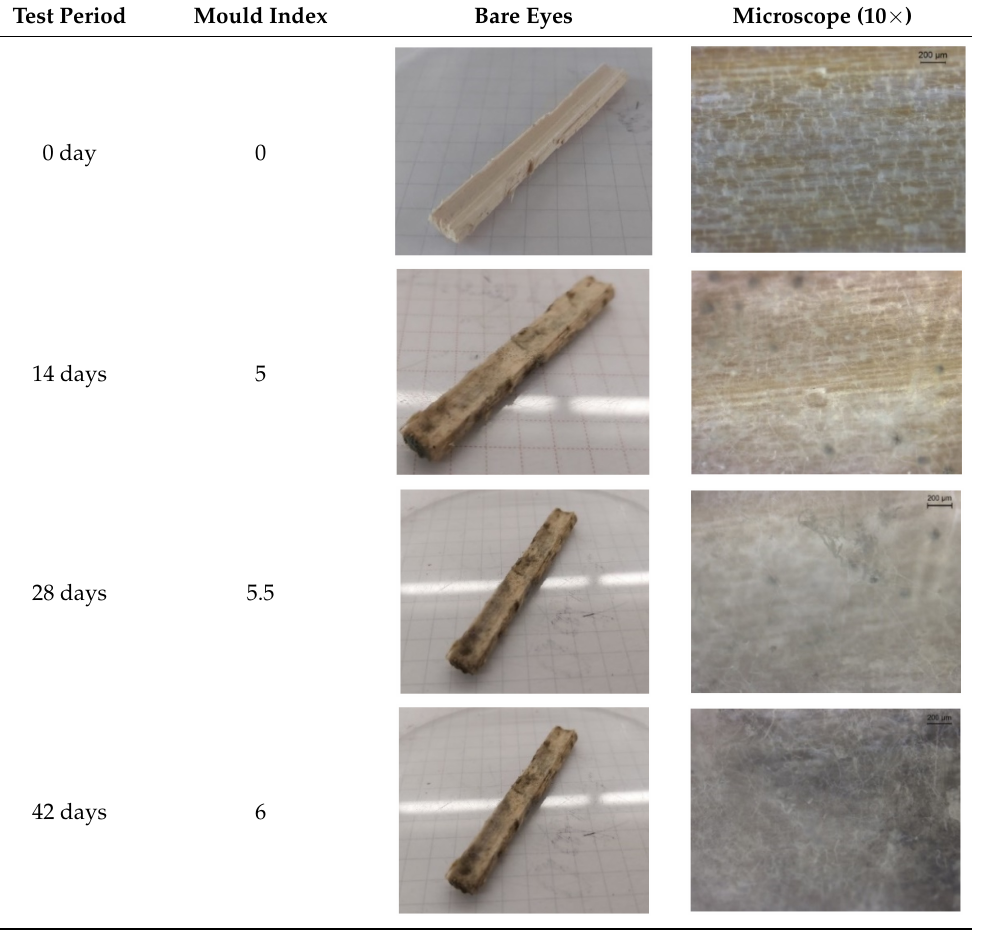
Table 6. Development of surface moulds in G2